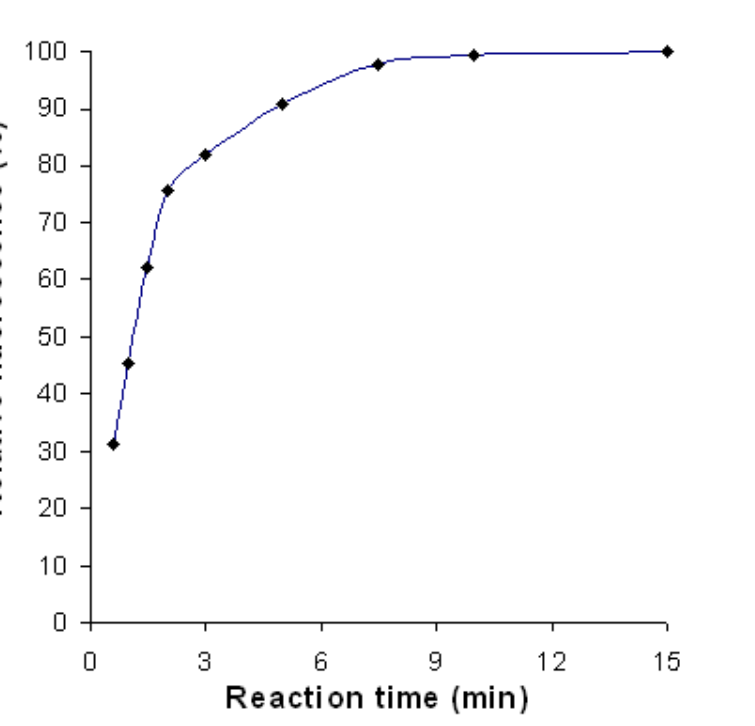
Figure 5. MBB-GSH adduct as a function of time. The GSH 20 µ M solution was derivatized at pH 9 with MBB. The relative fluorescence for the reaction time of 15 min was fixed at 100.